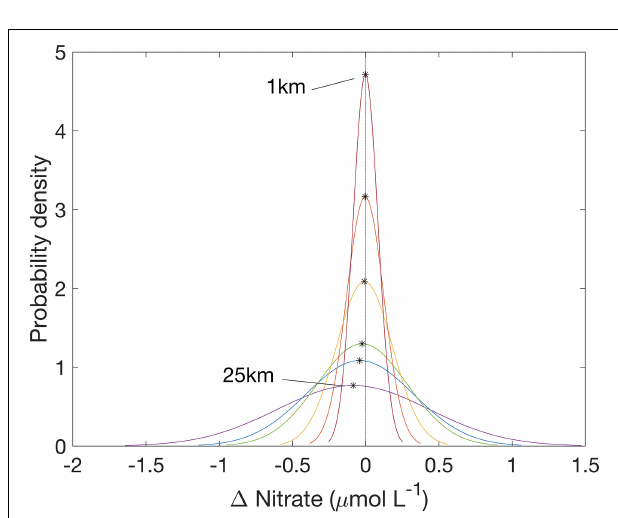
FIGURE 8 | Normal curve fit of error distribution in nitrate product from October 19, 2016. Black stars are the mean error at each spatial